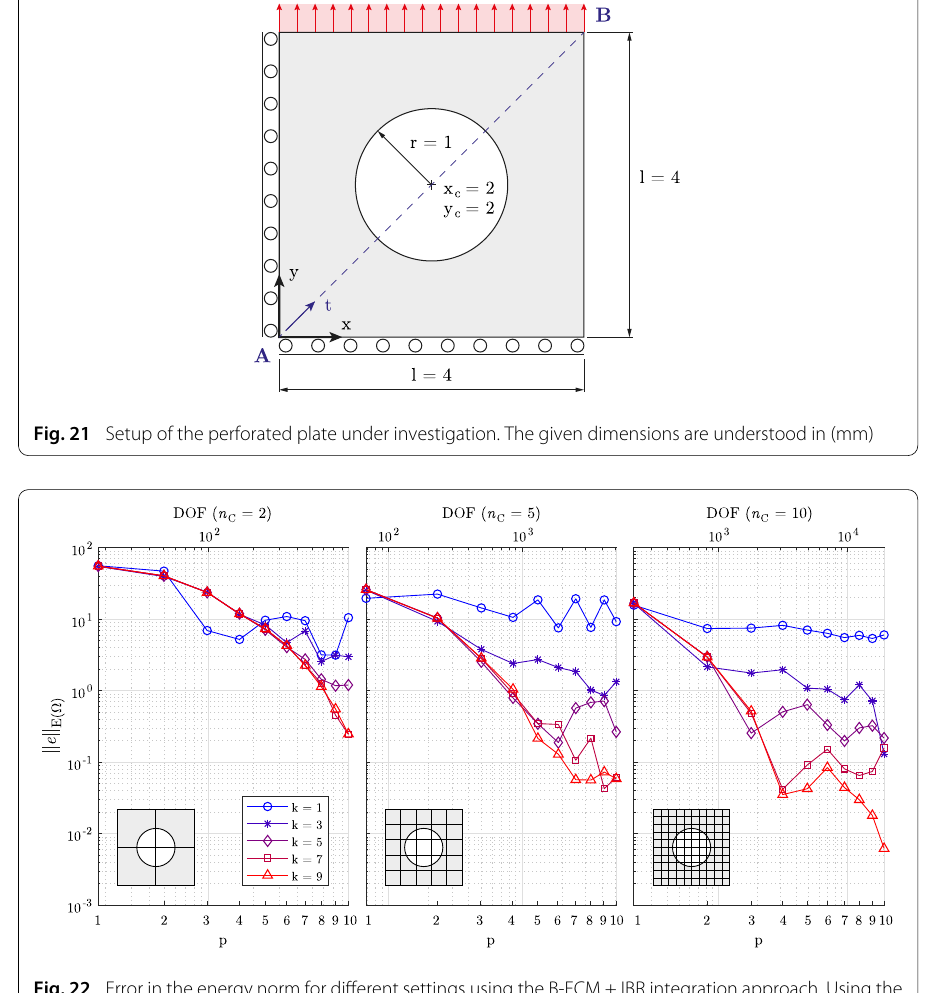
Fig. 22 Error in the energy norm for different settings using the B-FCM + IBR integration approach. Using the other compression techniques as well as using no compression results in the same depicted curves